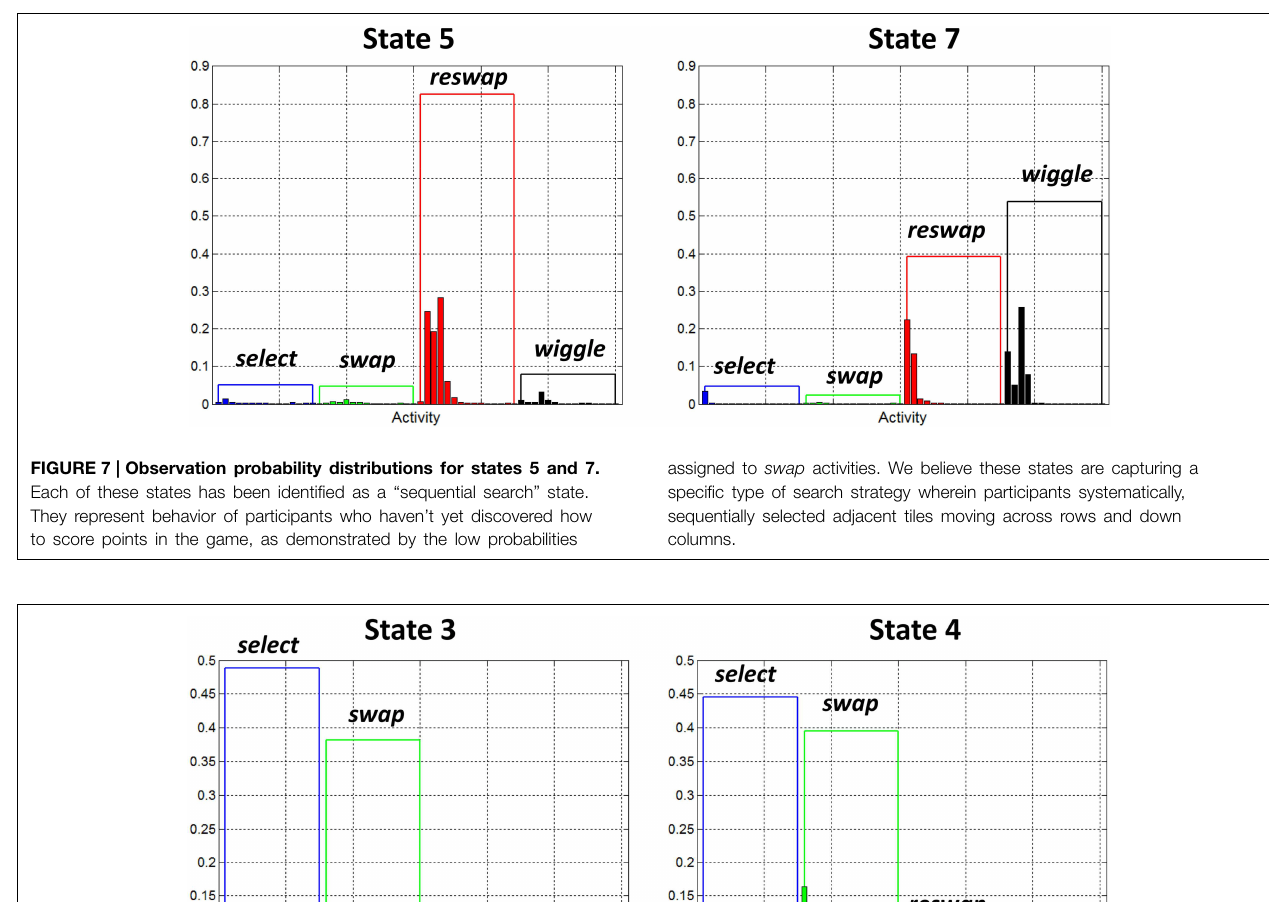
FIGURE 8 | Observation probability distributions for states 3 and 4. Each of these states has been identified as a “success” state. They represent behavior of participants who have discovered the